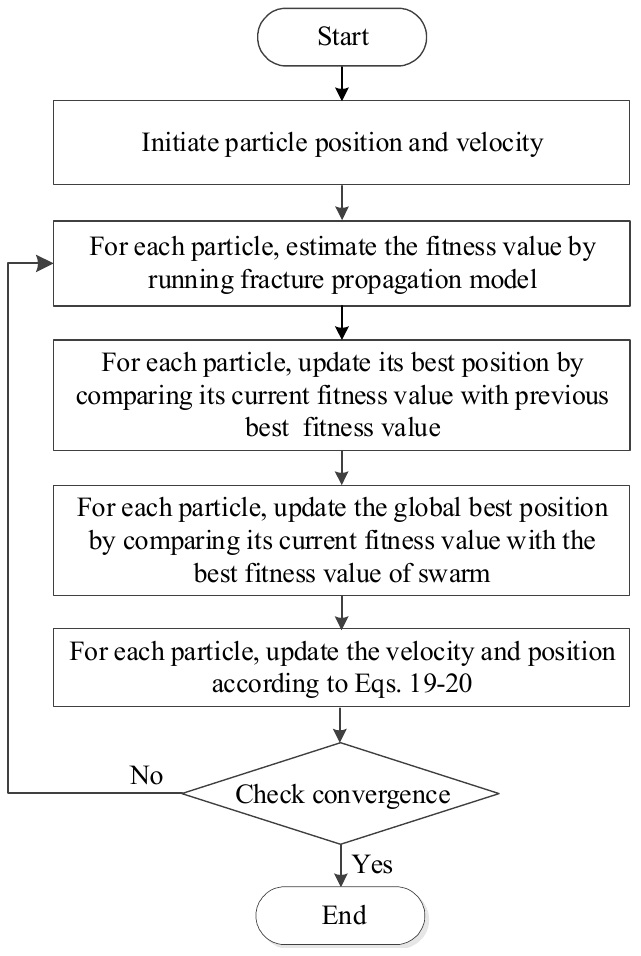
Figure 2. Flowchart of optimization scheme.